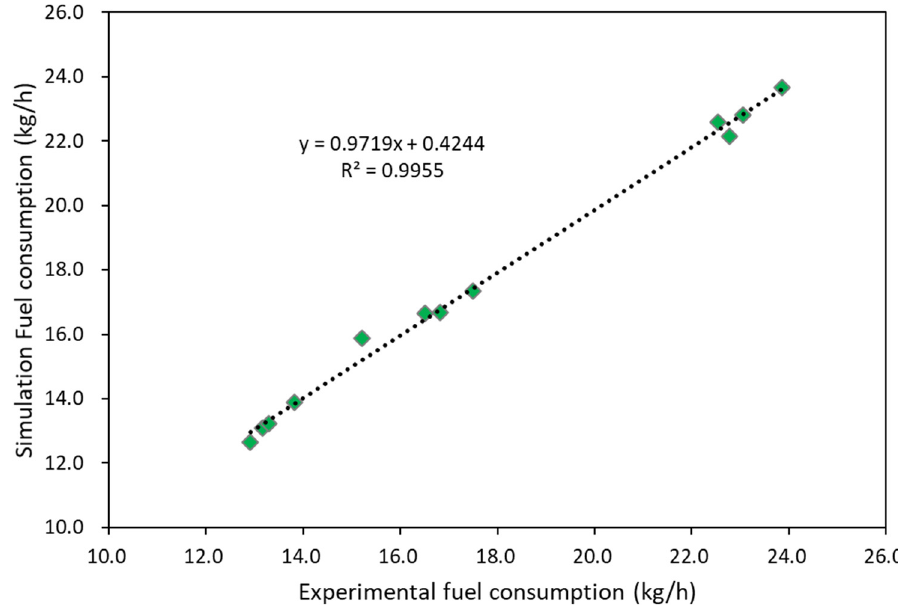
Figure 10. Regression analysis of fuel consumption during rotary